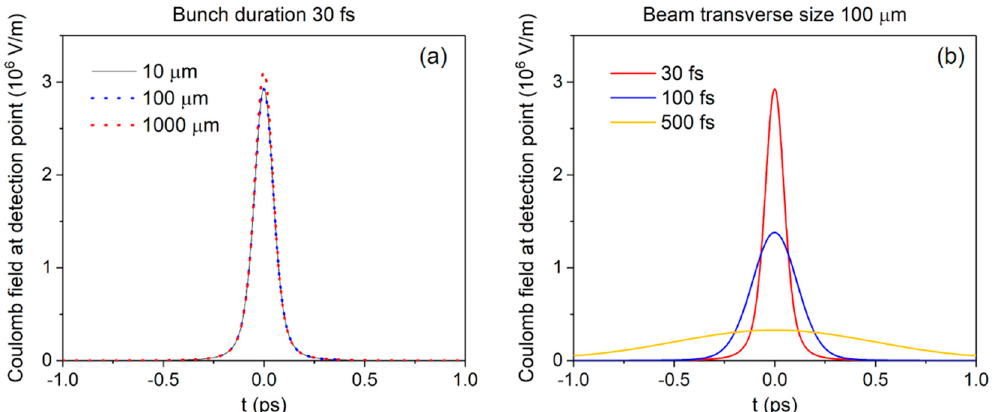
Figure 6. Examples of Coulomb field strength of an electron bunch with di ff erent divergences and bunch durations. ( a ) Coulomb field of 30 fs electron bunches with di ff erent transverse sizes. ( b ) Coulomb field of 100 µ m electron bunches with di ff erent bunch durations. The distance between the detection point to the center axis of the electron beam is r 0 = 3 mm in all cases.